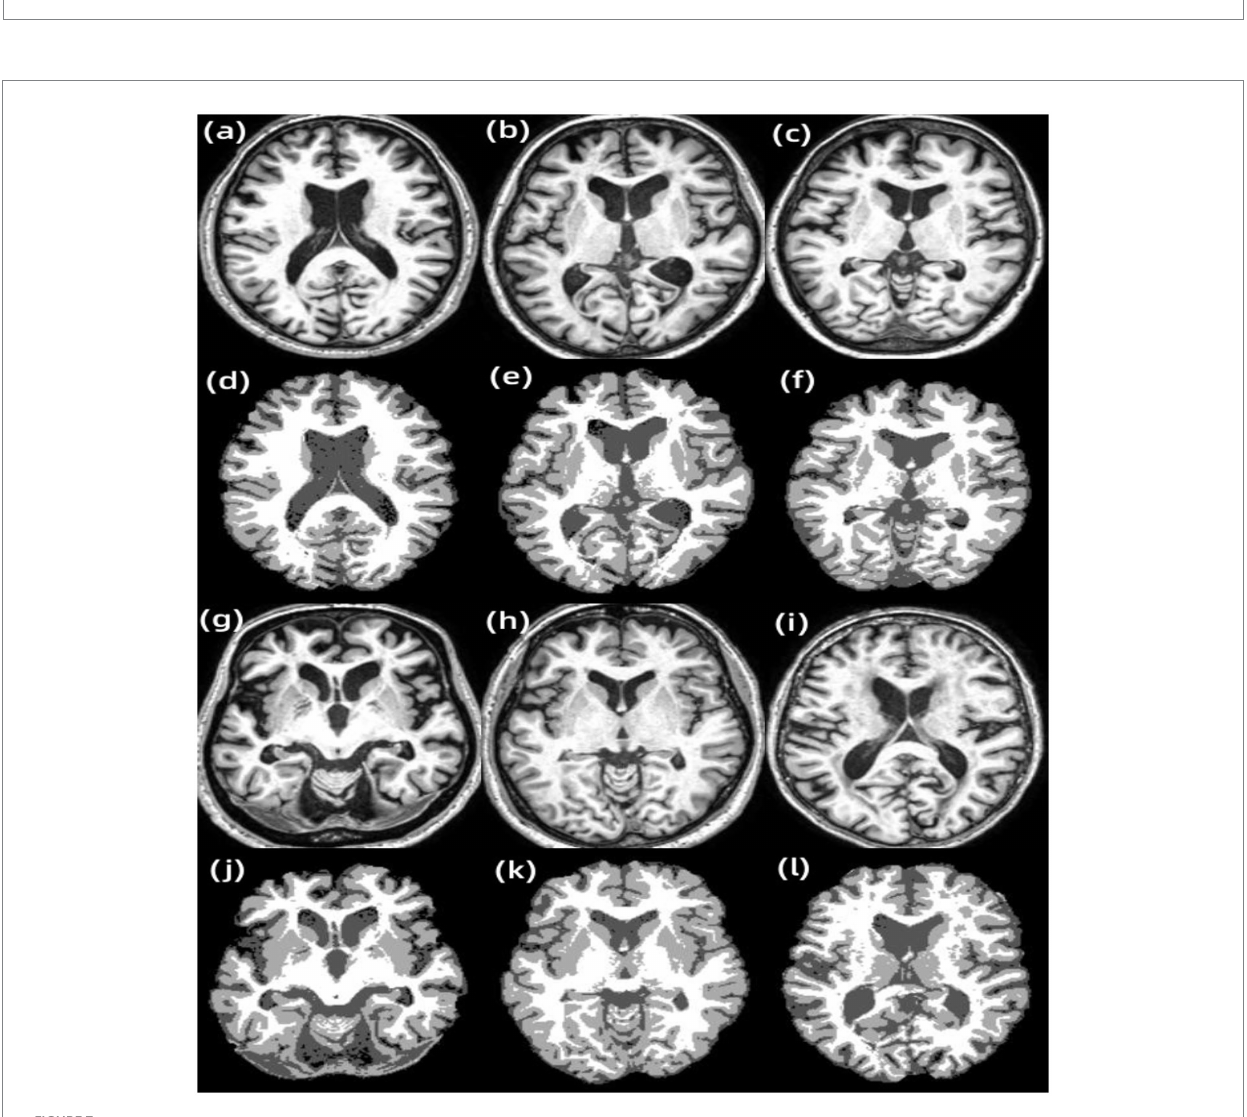
FIGURE 7 Results of other examples of LF-ARFCM algorithm segmentation. (A) Subject 1, (B) subject 2, (C) subject 3, (D) subject 1 segmentation result, (E) subject 2 segmentation result, (F) subject 3 segmentation result, (G) subject 4, (H) subject 5, (I) subject 6, (J) subject 4 segmentation result, (K) subject 5 segmentation result, and (L) subject 6 segmentation result.